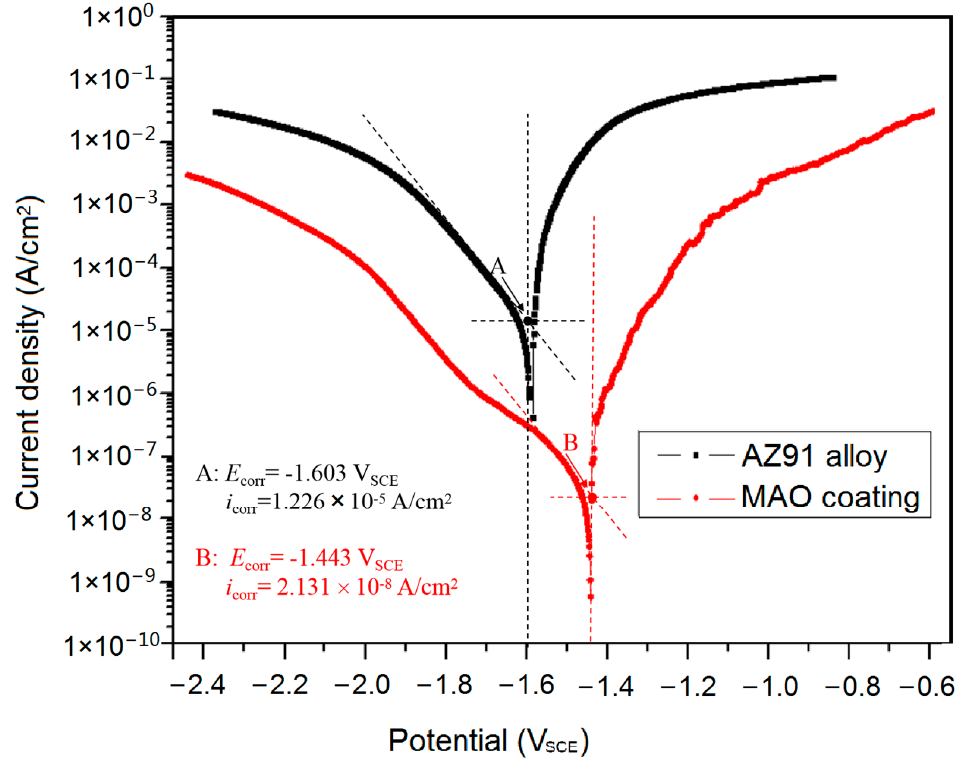
Figure 4. Polarization curves of AZ91 alloy, before and after MAO treatment after 1 h immersion in a 3.5% NaCl solution.